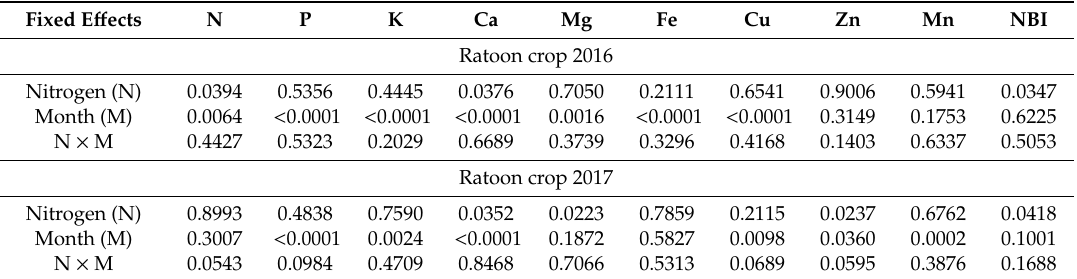
Table 4. Repeated measures analyses ANOVA p -values for the e ff ects of nitrogen, fungicides, sampling months, and their interactions on sugarcane leaf tissue nutrient composition of first ratoon crops.